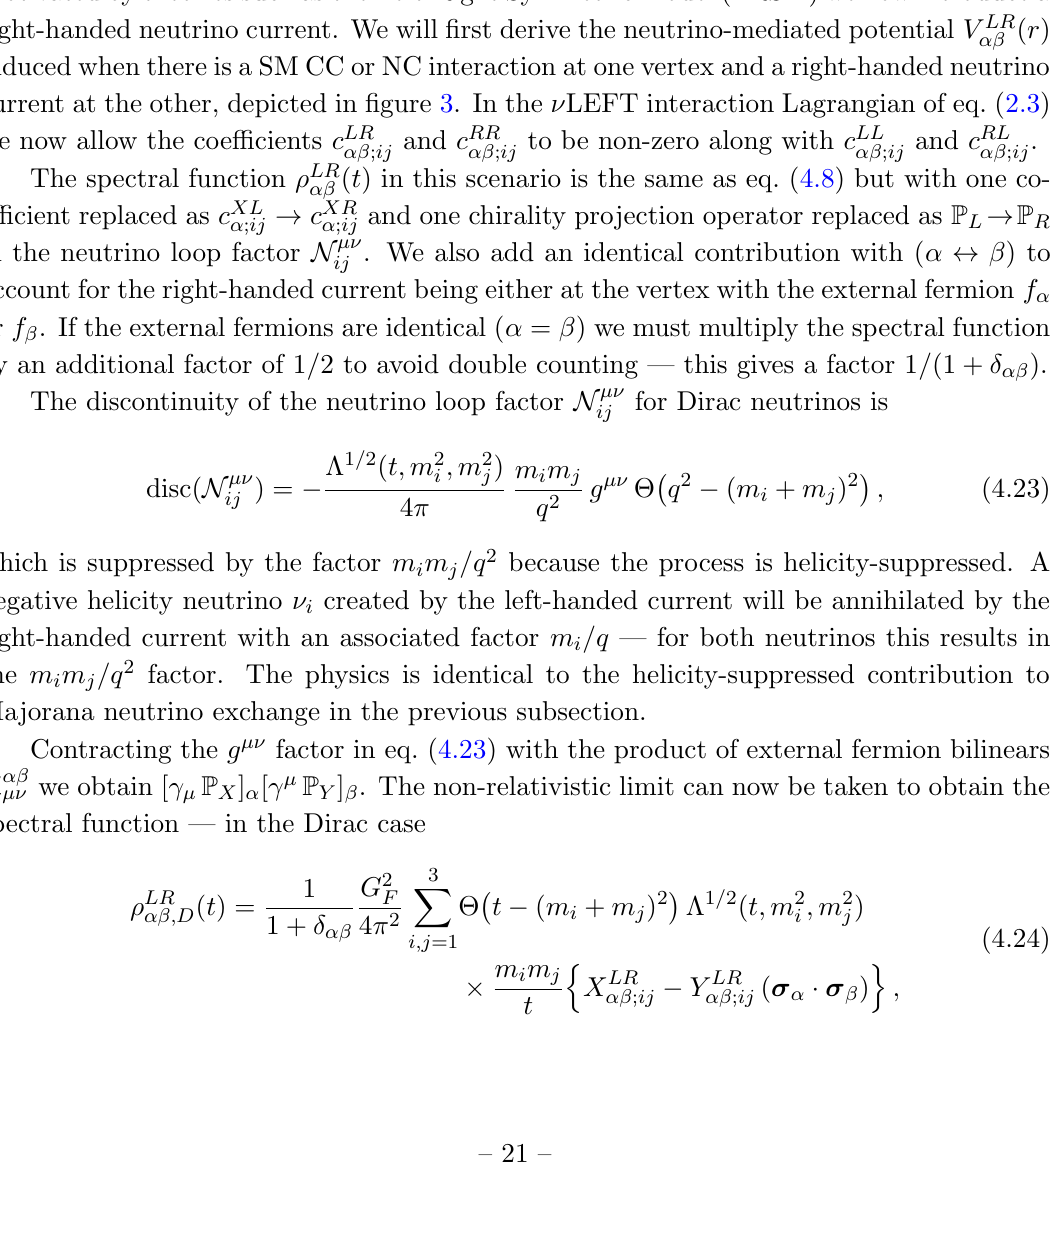
), scalar ( g XY ) or tensor (cid:11)(cid:12) ; ij (cid:11)(cid:12) ; ij